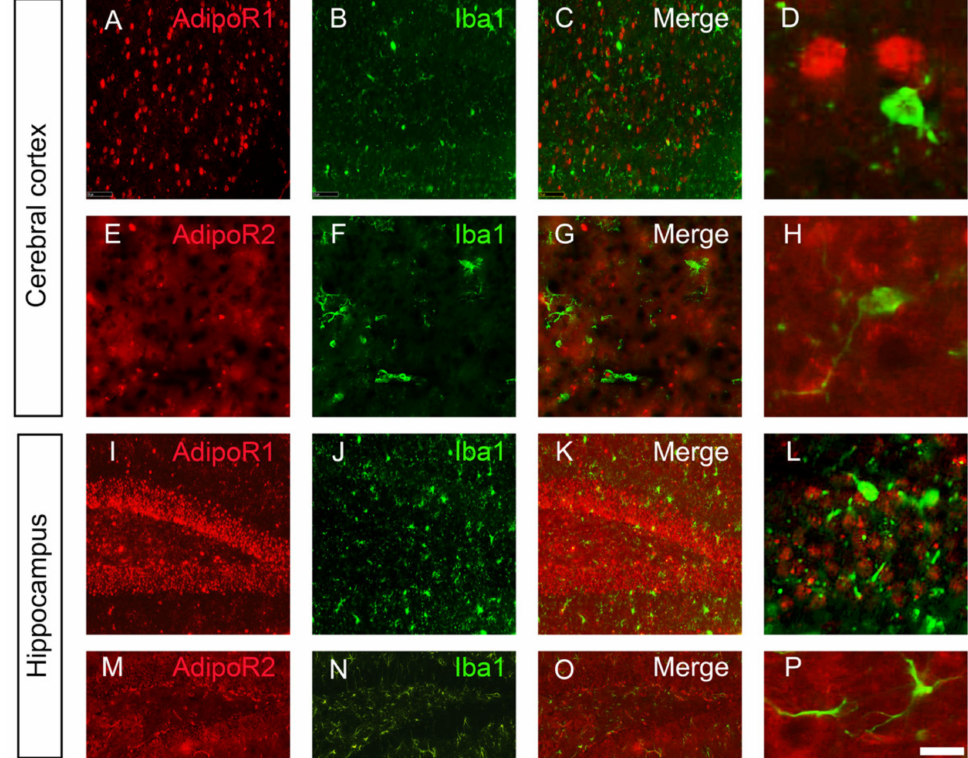
Figure 3. AdipoR1 and AdipoR2 are not strongly expressed by the microglia in the cerebral cortex and hippocampus. ( A ) AdipoR1 and ( E ) AdipoR2 immunohistostaining (red) with Iba1 microglial co-labelling (green, ( B , F )) in the cerebral cortex showing no co-expression ( C , D , G , H ). ( I ) AdipoR1 and ( M ) AdipoR2 immunostaining (red) with Iba1 microglial co-labelling (green, ( J , N )) in the dentate gyrus of the hippocampus showing no co-expression ( K , L , O , P ). ( D , H , L , P ): Higher magnifications. Scale bar = 7 µ m ( D , H ), 14 µ m ( L , P ), 200 µ m ( A – O